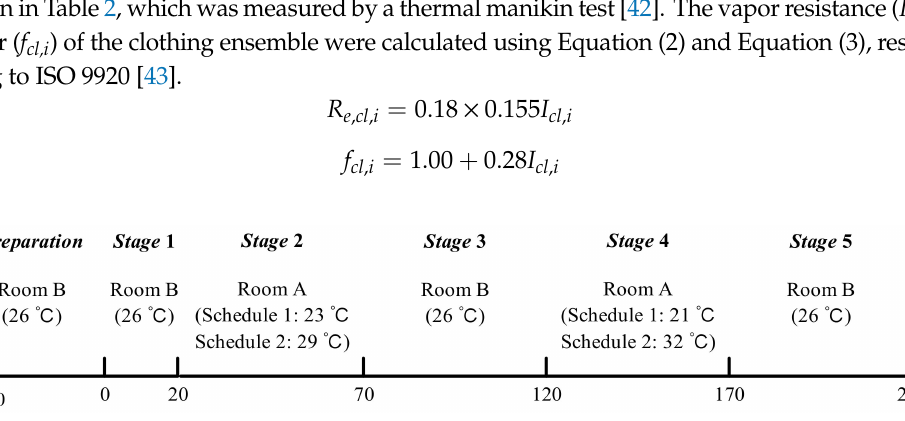
Figure 2. Procedures of